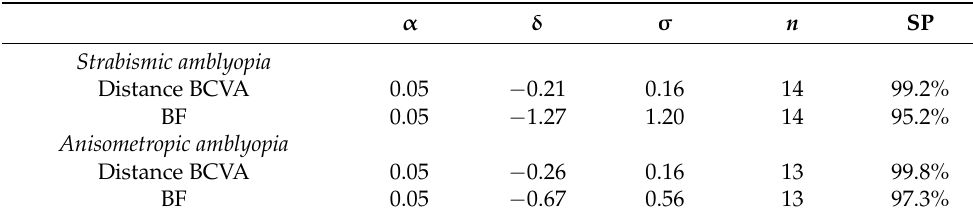
Table 1. Statistical power calculations associated with the analysis of changes in distance BCVA and BF for the strabismic and anisometropic groups. Abbreviations: α , Type I error probability (probability that we will falsely reject the null hypothesis; δ , difference between means; σ , standard deviation of difference in the response of matched pairs; n , number of subjects; SP, statistical power. BCVA, best corrected visual acuity; BF, binocular function score.